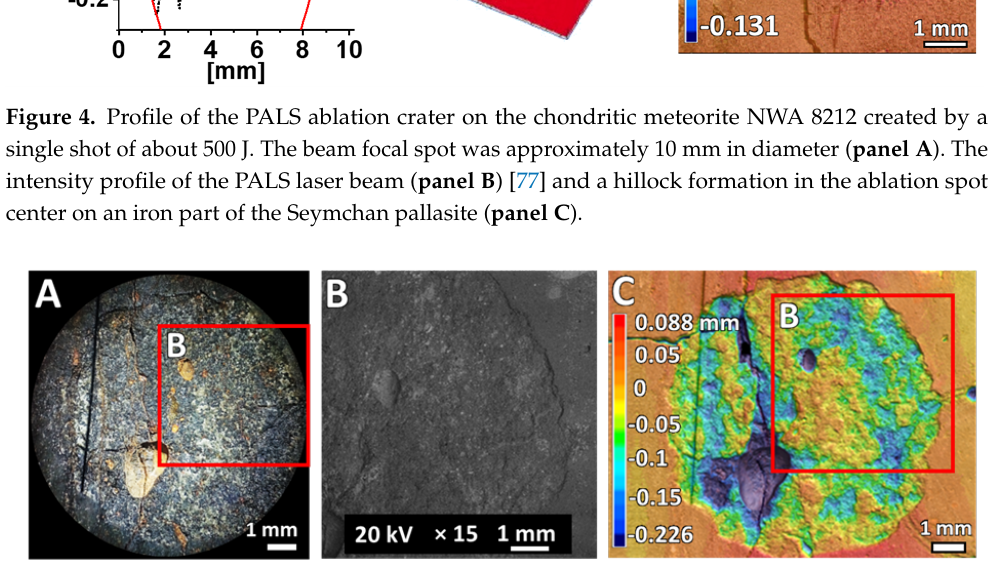
Figure 5. Ablation site for the PALS laser (single shot, 500 J) on the chondritic meteorite NWA 8212, examined by optical microscopy ( panel A ), scanning electron microscopy ( panel B ), and optical profilometry ( panel C ). The diameter of the spot was about 10